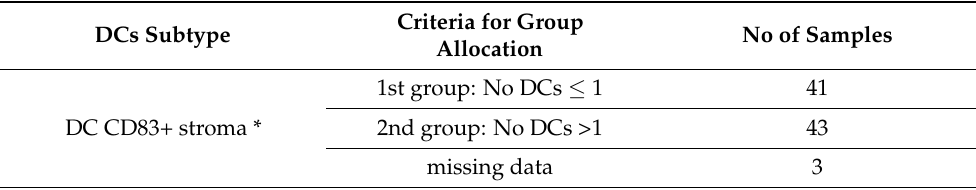
Table 5. Criteria for allocation of EC samples to groups based on the numerosity of different DC subtypes infiltrating cancerous tissues. These criteria were uniform for each antibody used for IHC staining: the first group included samples with DC counts less than the calculated number of the first quartile (Q1); the second group included DC counts greater than or equal to Q1 and less than the median value (Me); the third group included DC counts greater than or equal to Me and less than the third quartile (Q3); the fourth group included DC counts greater than Q3. * There was an exception for staining with the anti-CD83 antibody. The Q1 was 0 for the number of DCs 83+ in stroma and border, so four groups could not be distinguished. Two groups were created instead based on the Me value (the first group contained samples with DC counts less than or equal to Me; the second group included DC counts greater than Me). Rows with missing data include samples in which the numbers of DCs could not be established due to tissue damage during slide preparation or inappropriate IHC